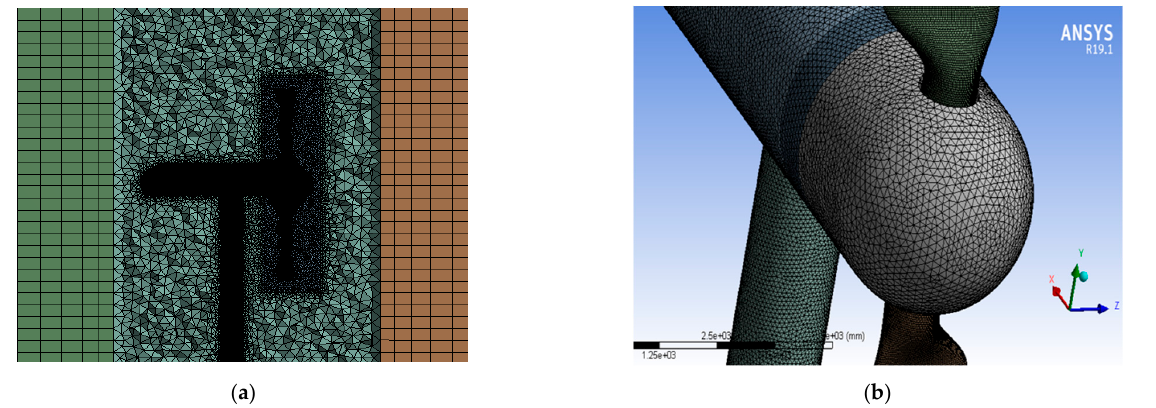
Figure 1. ( a ) Mesh detail of external and internal rotating domain ( b ) mesh of